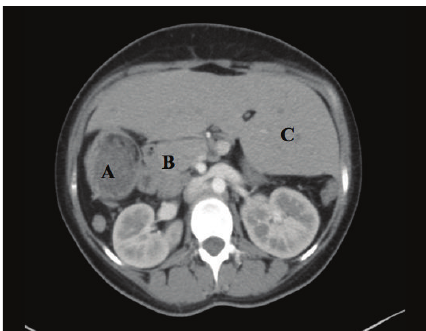
Figure 1: CT scan of the chest with contrast demonstrating situs ambiguous: (A) a right-sided stomach, (B) multiple splenules on the right, and (C) the liver in the midline occupying both right and left portions of the abdomen.